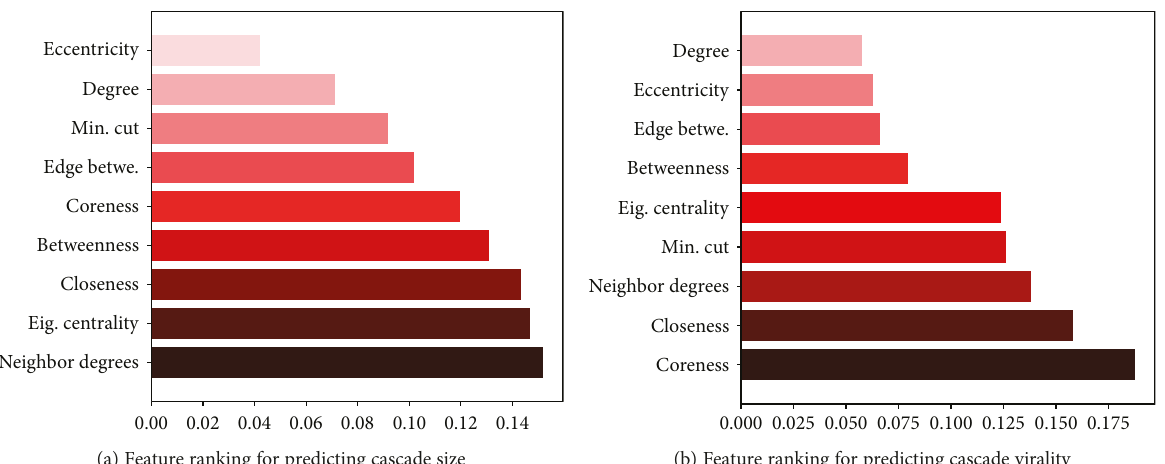
w i = 1 , where w i is the feature rank for the feature i . The method used for Figure 11: The fi gure shows feature ranking such that ∑ i generating the importance is random forests where the importance of a feature increases whenever a split in the tree using that feature minimizes the prediction error